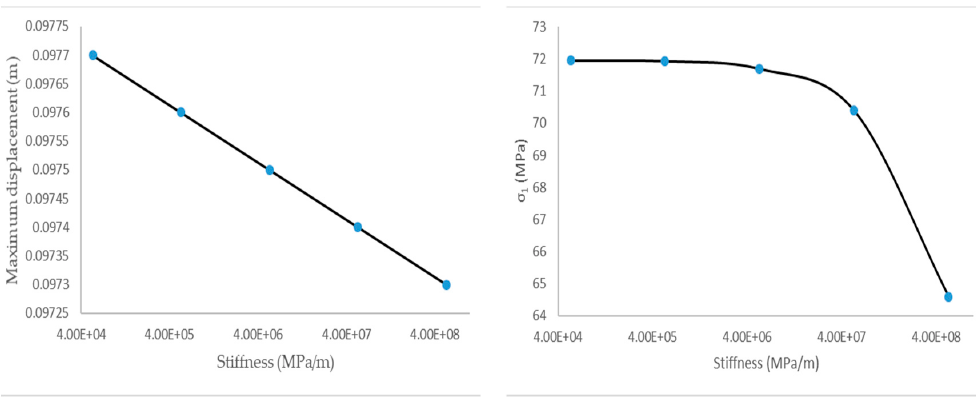
Figure 8. Variation in maximum displacement and σ 1 (major prinicipal stress) with increase in interface stiffness.